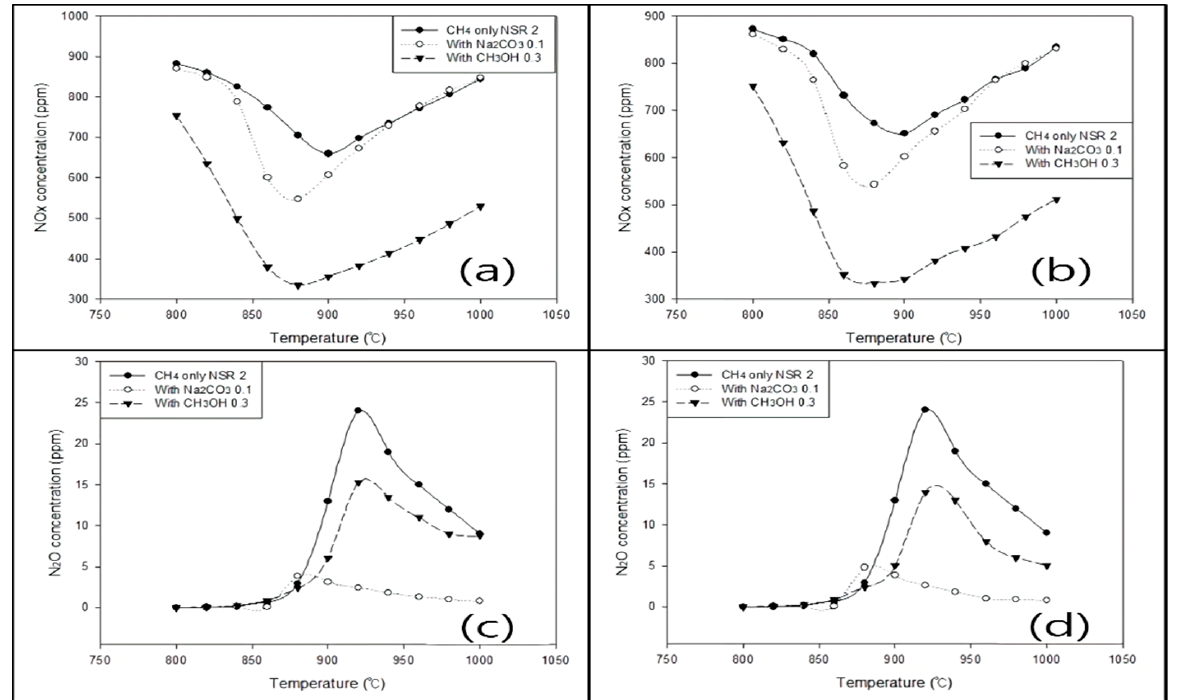
Figure 5. ( a , c ) Experimental and ( b , d ) simulated (identical conditions) effects of temperature and additives on the levels of ( a , b ) NO x and ( c , d ) N 2 O.